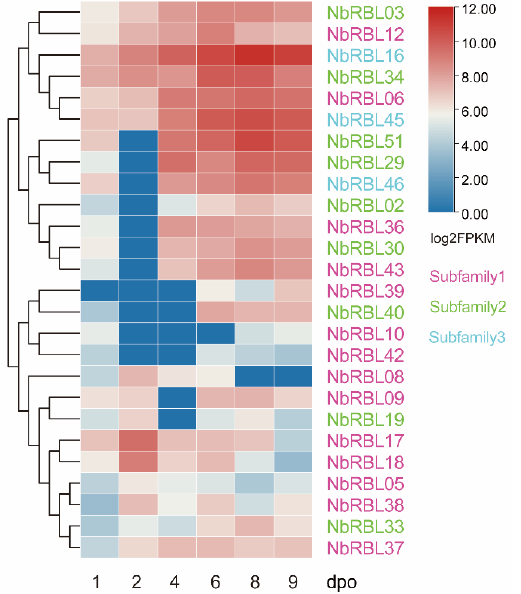
Figure 5. Expression patterns of Nbrbls in the B. mori embryo infected by N. bombycis . The expression level of Nbrbls in N. bombycis -infected embryo of B. mori after 1–9 days post oviposition (dpo) was calculated from the RNA-Seq data we published before [30]. Each column represents a time-point, each row represents a gene. For detailed FPKM of Nbrbl s, see Table S1.